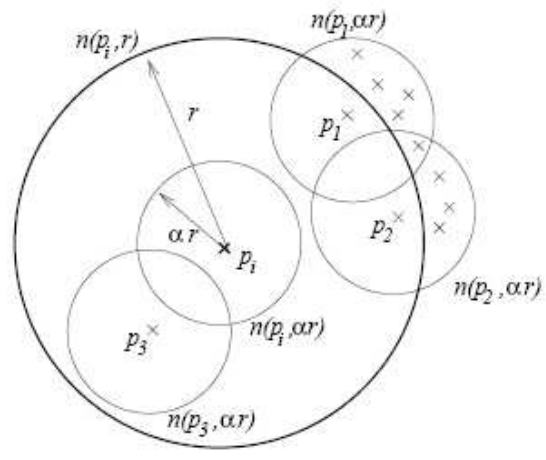
Figure 5. Definition of